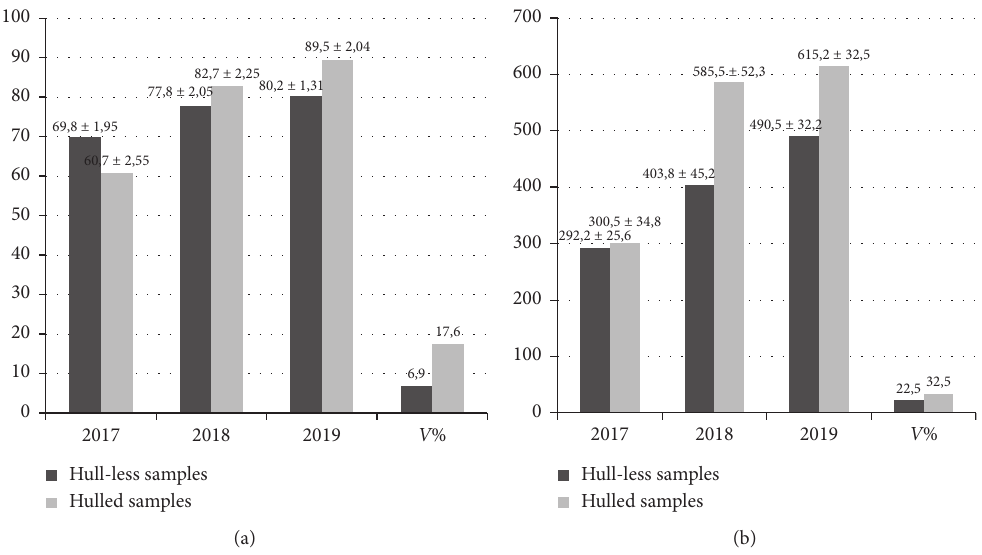
Figure 1: Average values and variability of the traits: (a) plant height and (b) grain yield.